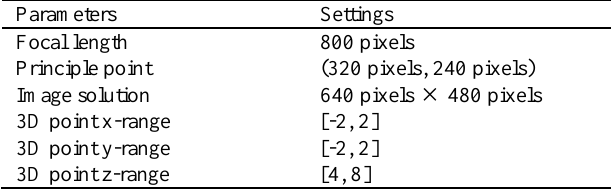
Table 1. Parameter settings for simulated data